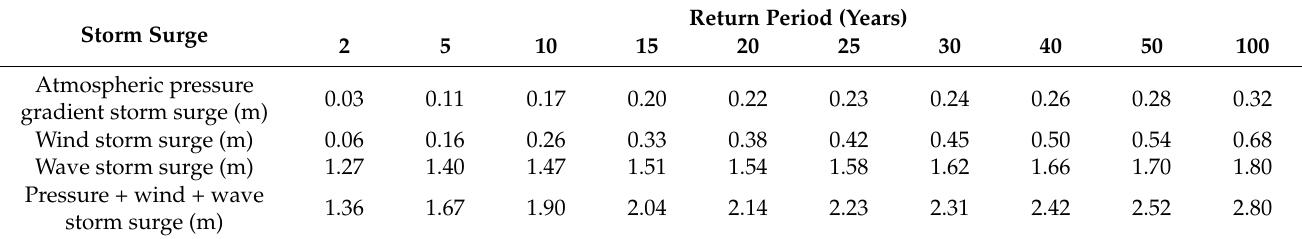
Table 2. Storm surge levels in La Mancha area, data from Silva et al.